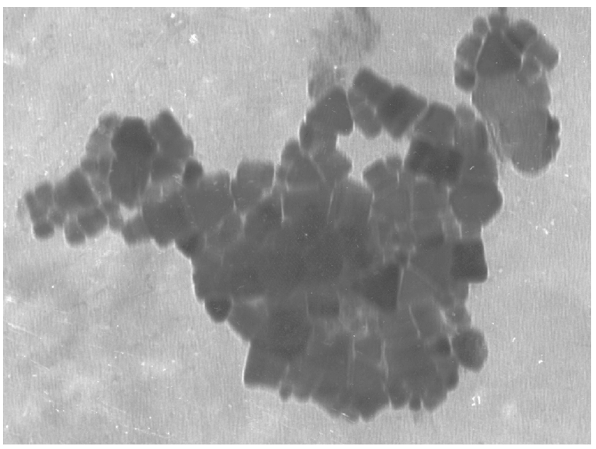
Figure 3: TEM image of CdS nanoparticles.